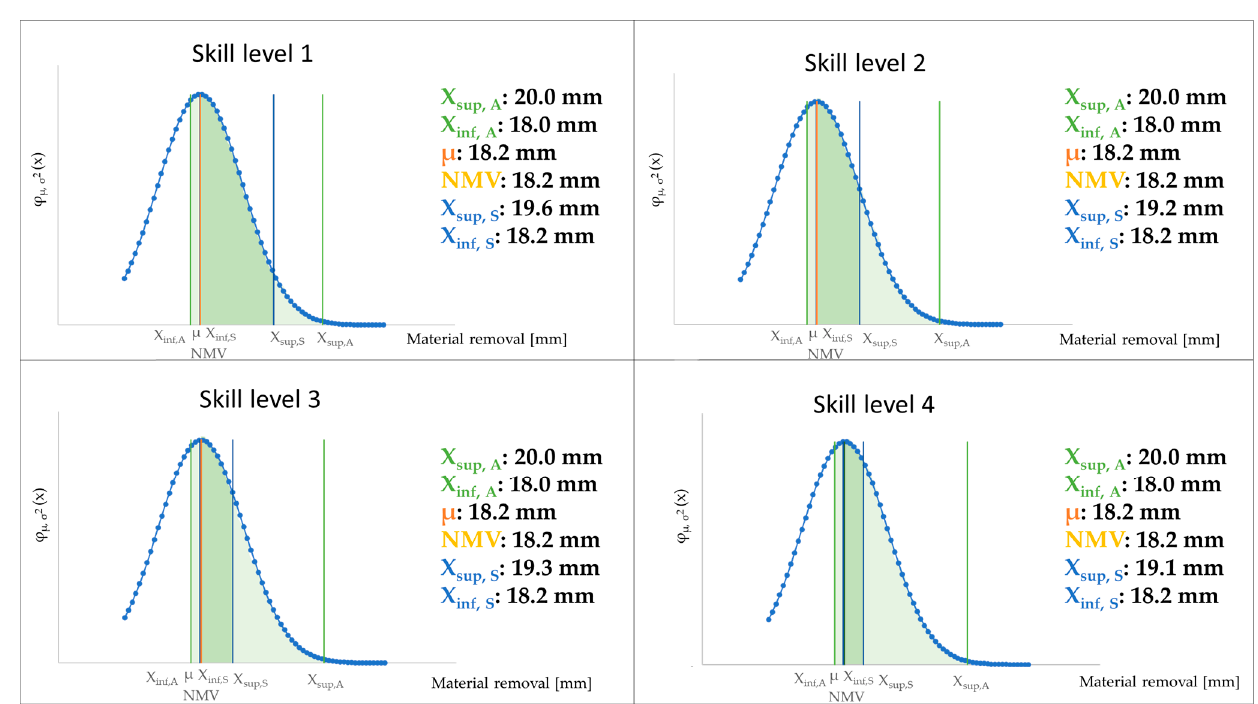
Figure 15. Gaussian distribution of drilling.